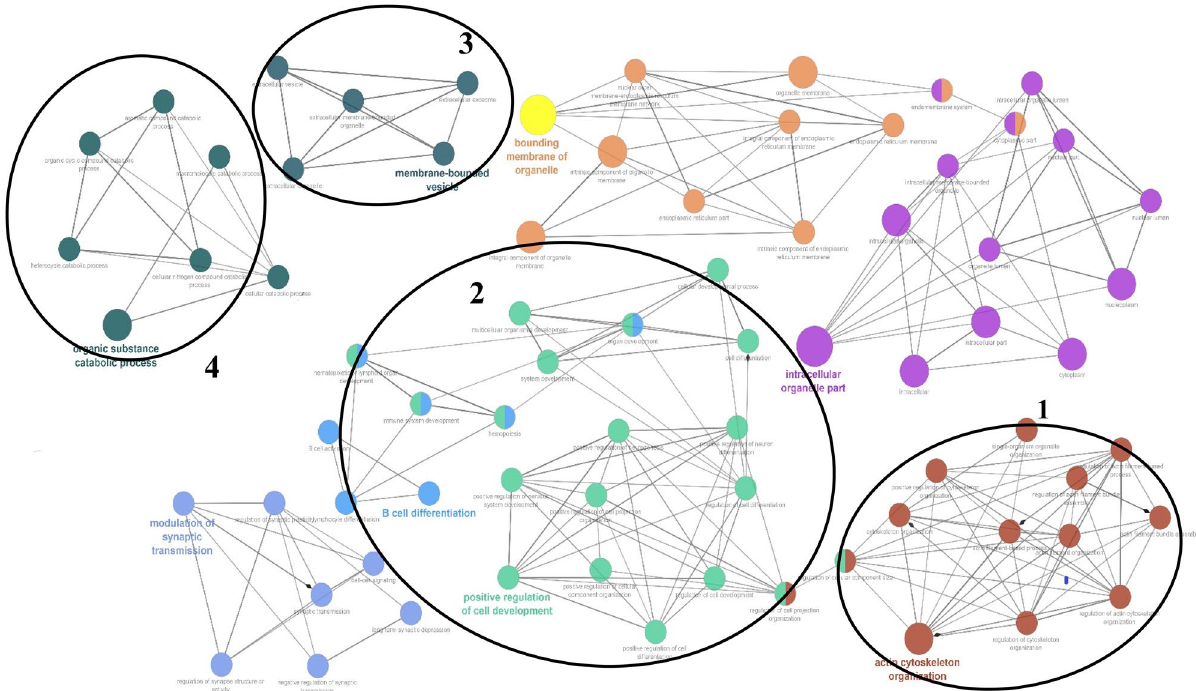
Figure 5. Gene-network interactions between all the genes reported in the regions containing CNVRs in Afghan sheep breeds, produced by Cytoscape functional annotation tool (http:// www. cytos cape. org/). Circles of different colors represent (biochemical pathways) and the lines between these circles indicate the interactions between these pathways with each other. Zone 1 include the genes that affecting the skeletal muscle, zone 2 influence the birth weight, fertility, embryonic development and skeletal morphology, zone 3 is containing the genes that effect on skeletal development, cartilage structure, and joint function and zone 4 plays a role in fetal development and